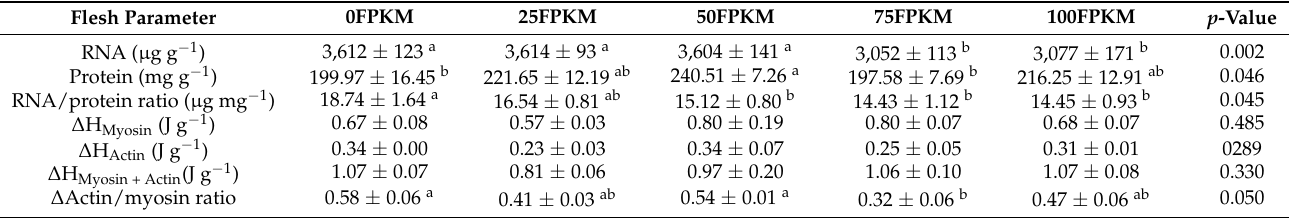
Table 5. Protein synthesis capacity and amount of myosin and actin in white muscle of sex-reversed red tilapia observed at the end of 12 weeks of dietary treatment.